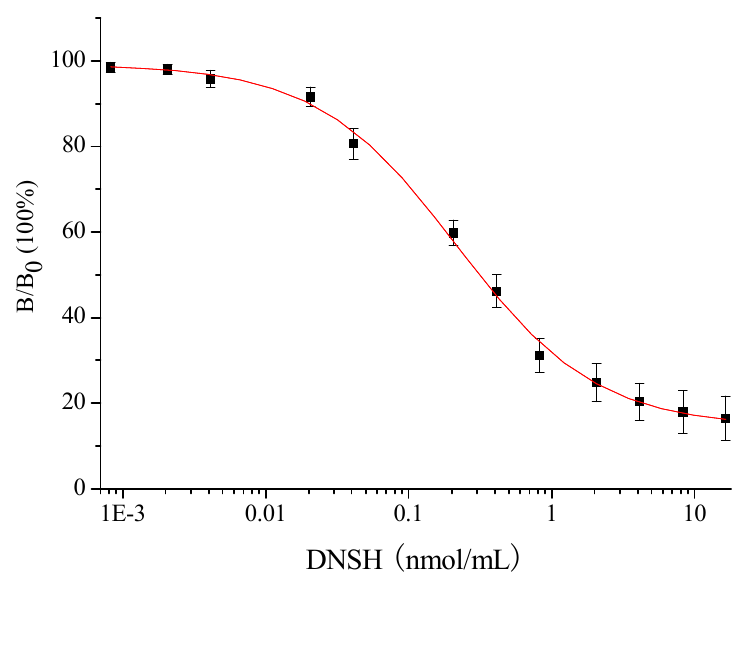
Figure 5. Standard curve of indirect ELISA for DNSH